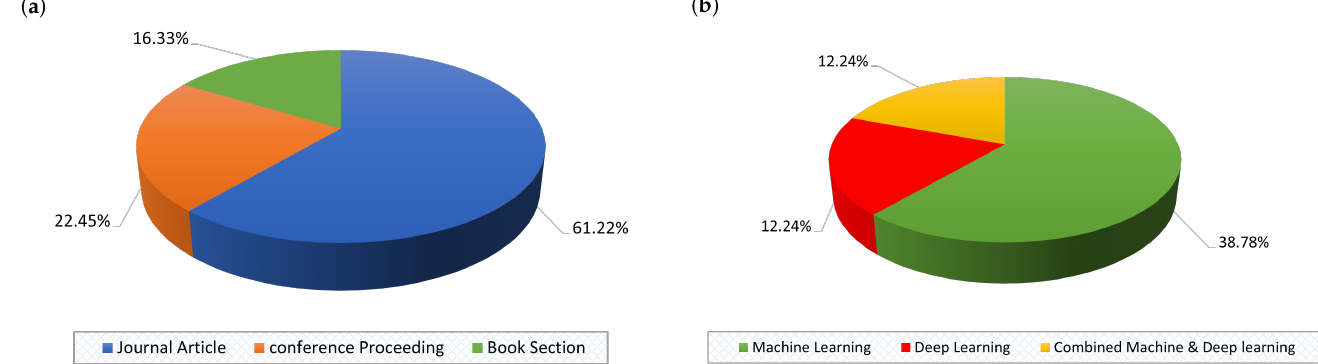
Figure 6. Distribution of selected studies according to ( a ) Publication Per Type, ( b ) Publication Per